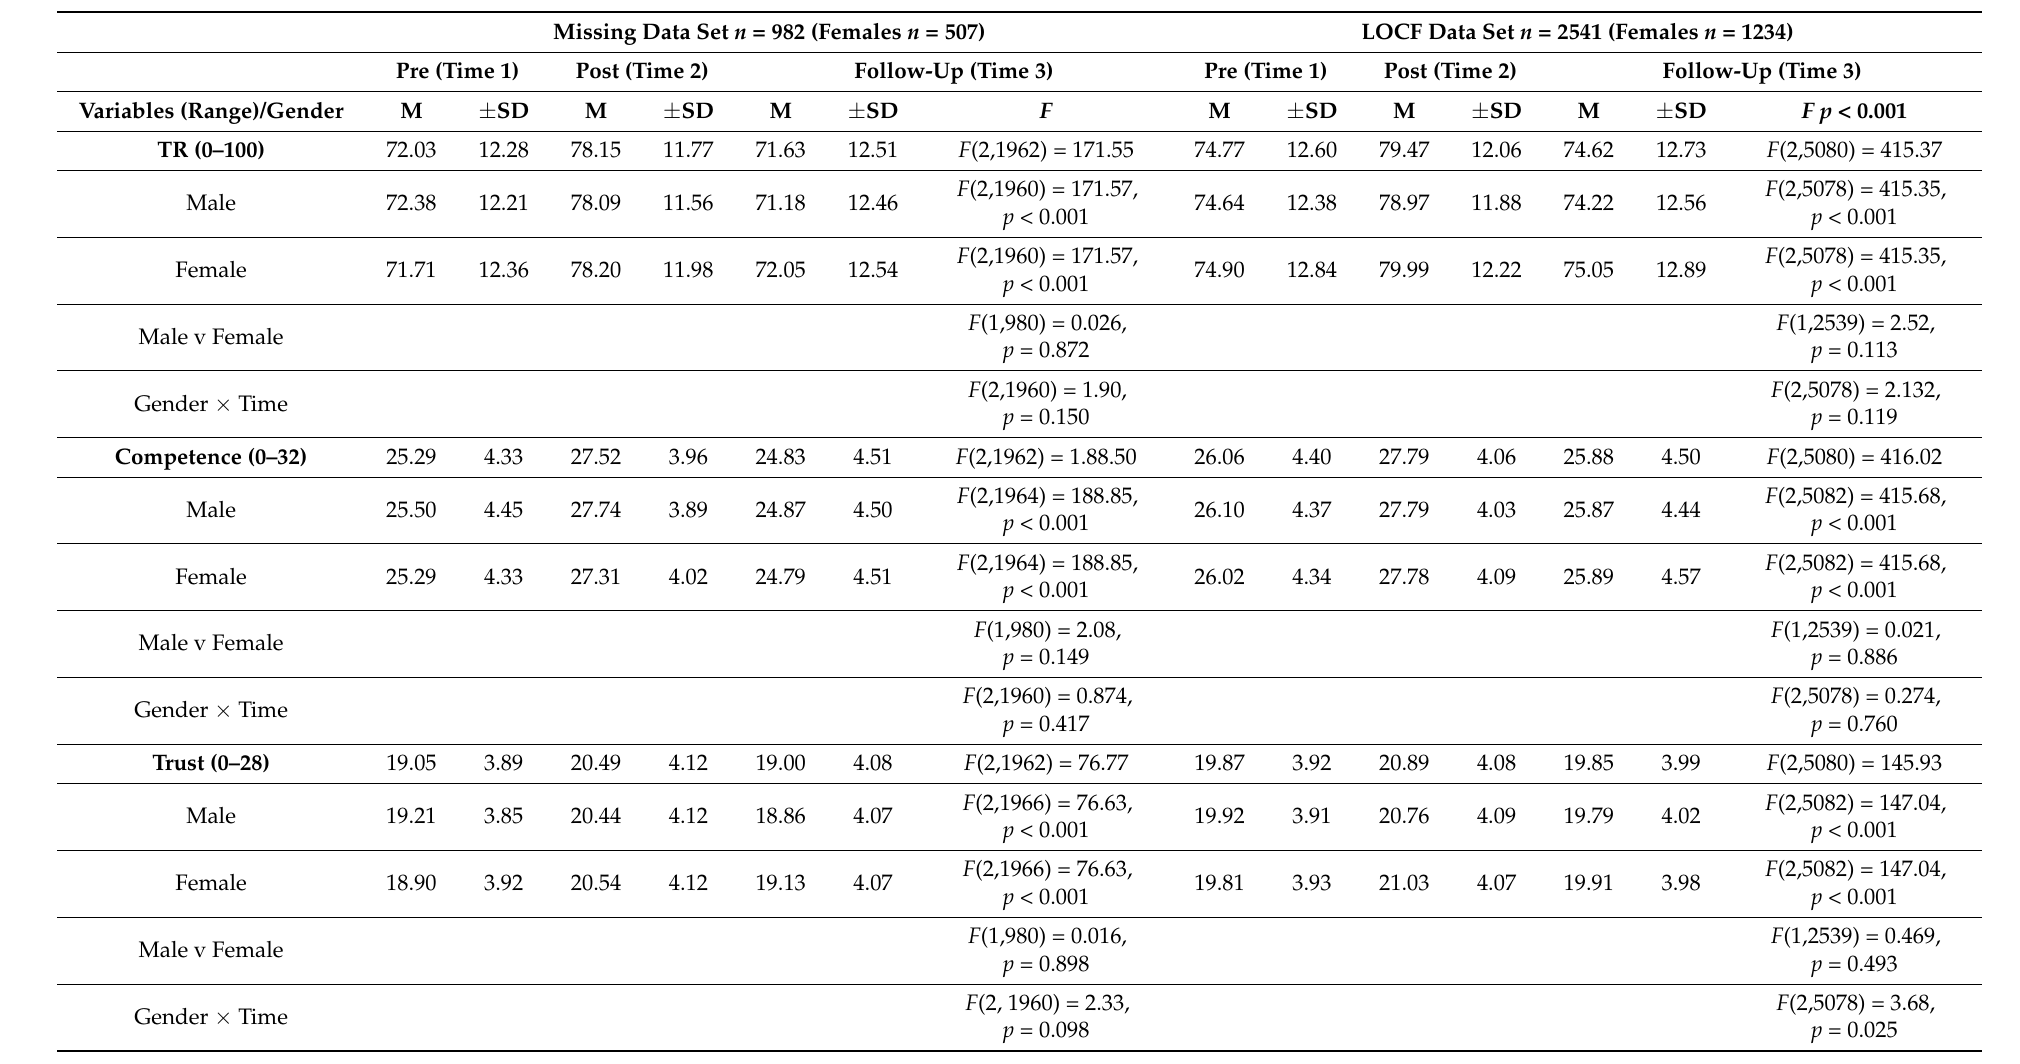
Table 1. Pre, post, and follow-up mean scores for total resilience (TR) and subscales by gender (Missing Data and last observation carried forward (LOCF) datasets). Missing Data Set n = 982 (Females n = 507) LOCF Data Set n = 2541 (Females n =